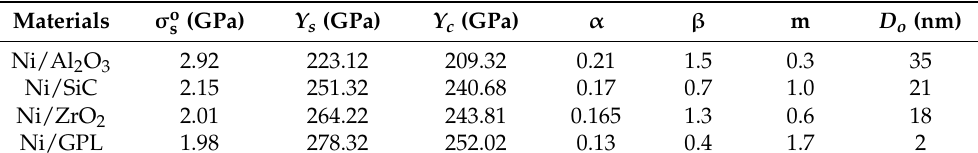
Table 2. Fitted parameter values from the MD simulations.